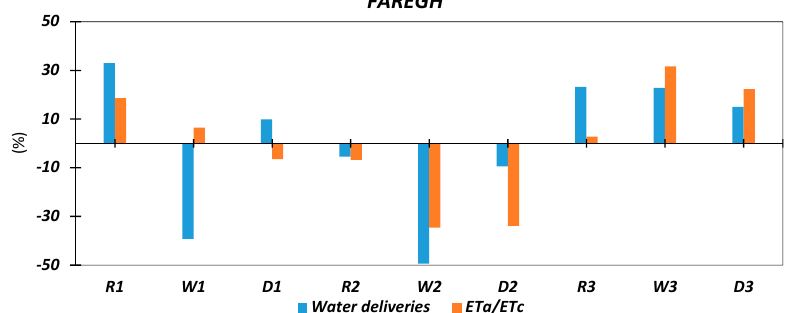
Figure 12. Faregh district; relative anomalies in quarterly water delivery W d and relative evapotranspiration ET a / ET c ; 1,2,3 and R, W, D: see Figure 6.